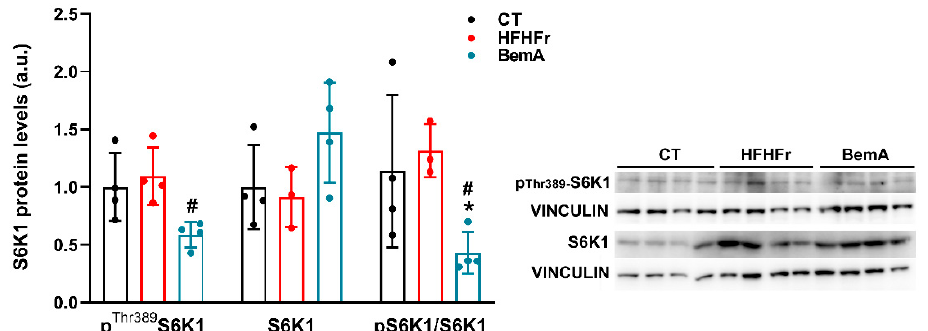
Figure 7. Effect of Bempedoic acid on S6K1 protein levels in liver samples. Bar plots show liver phosphor-Thr 389 S6K1, total S6K1 protein levels, and the ratio of phosphor to total S6K1 protein levels from control (CT), high-fat high-fructose (HFHFr), and bempedoic acid (BemA)-treated rats. The results are expressed as the mean ± SD of four pooled samples, obtained by mixing equal amounts of tissue from two rats, for each condition. On the right side of the figure, representative western blot bands corresponding to the three different study groups are shown. a.u.: arbitrary units. Data were analyzed by one-way ANOVA followed by Tukey’s post-hoc test. * p < 0.05 vs. CT; # p < 0.05 vs. HFHFr.